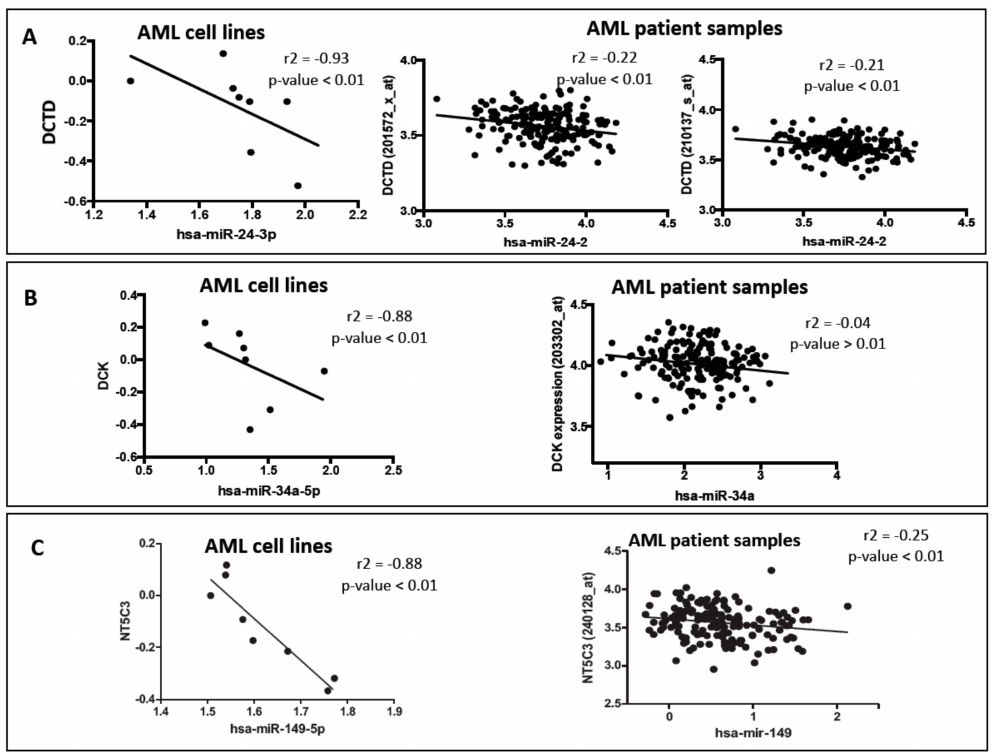
Figure 3. Correlation of miRNAs with nucleoside analog pathway gene expression in acute myeloid leukemia (AML) cell lines and patient samples from The Cancer Genome Atlas (TCGA) database. ( A ) Correlation between DCTD and hsa-miR-24a-3p. ( B ) Correlation between DCK and hsa-miR-34a-5p. ( C ) Correlation between NT5C3 and